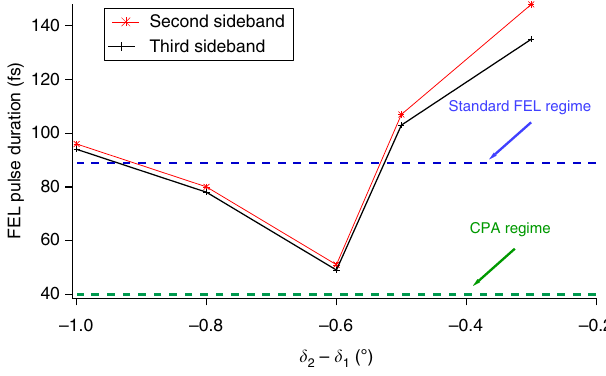
Figure 4 | Compression of FEL pulse versus compressor setting. Measured pulse duration as a function of the difference between the diffraction angles of the compressor gratings. Two sets of data are reported, obtained by the analysis of the second and third sideband, respectively, of the photoelectron energy spectrum. The two horizontal dashed lines correspond to the pulse duration expected when the FEL is operated in standard (no seed stretching, no FEL compression) or CPA